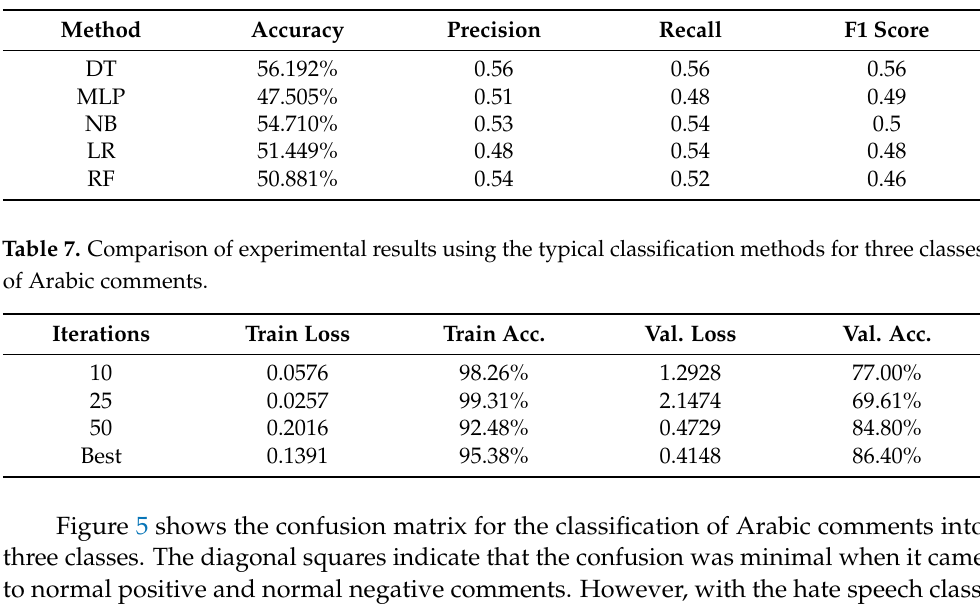
Table 6. Comparison of experimental results using the typical classification methods for the three classes of Arabic comments.